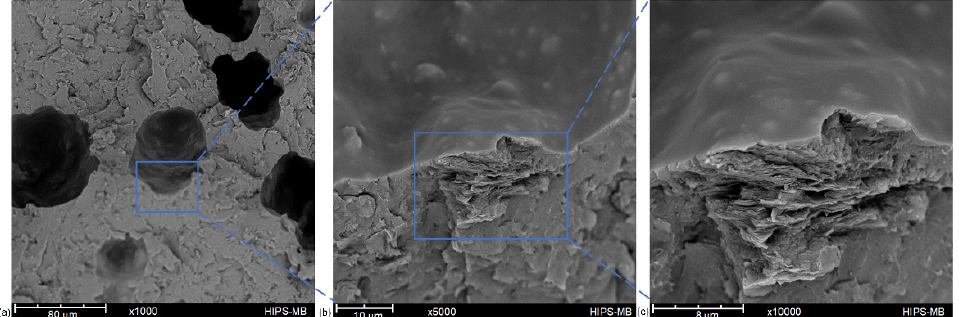
Figure 3. Cross-section of masterbatch filament at different magnifications: ×1000 magnification ( a ); ×5000 magnification ( b ); ×10,000 magnification ( c ).